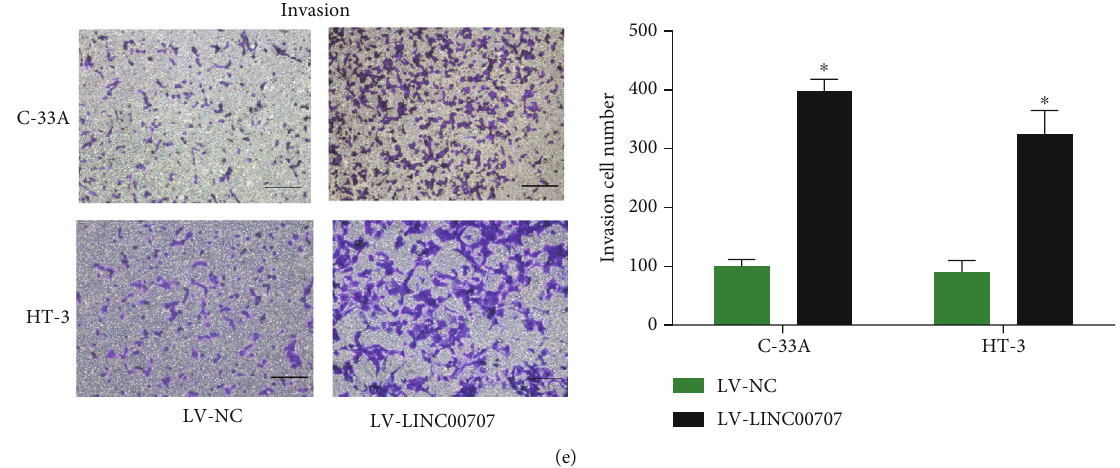
Figure 2: LINC00707 induced cervical cancer cell growth in vitro. (a, b) LINC00707 expression in C-33A and HT-3 cells infected with LV- LINC00707 was assessed by RT-qPCR assay. (c) Ki-67 positive cell ratio. (d, e) Cell migration and invasion ( scalebar = 50 μ m). ∗ P < 0 : 05